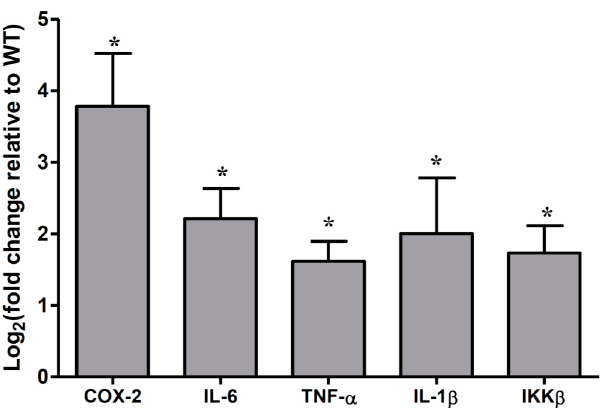
Figure 1. Cytokines were significantly upregulated in colonic epithelial cells of Muc2 − / − mice at the age of 178 days. * p < 0.05, compared with Muc2 +/+ mice colonic epithelia. The columns were presented as the mean ± SD; n = 5 for each group. WT, Muc2 +/+ mice. TNF- α —tumor necrosis factor- α .